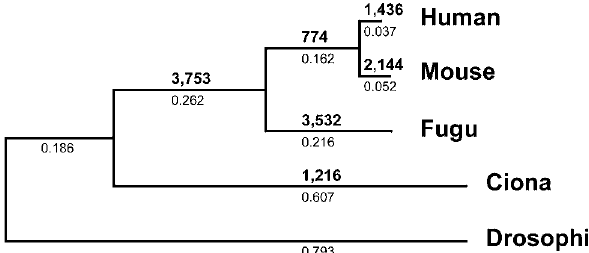
Figure 4. Phylogenetic Analysis of the Four Chordates with Drosophila as an Outgroup This phylogenetic tree is based on 766 concatenated single copy protein sequences totaling 313,797 amino acid positions with branches propor- tional to the amount of change. Numerals in bold above the branches indicate the number of gene duplications occurring in each lineage; numerals below indicate branch lengths. DOI: